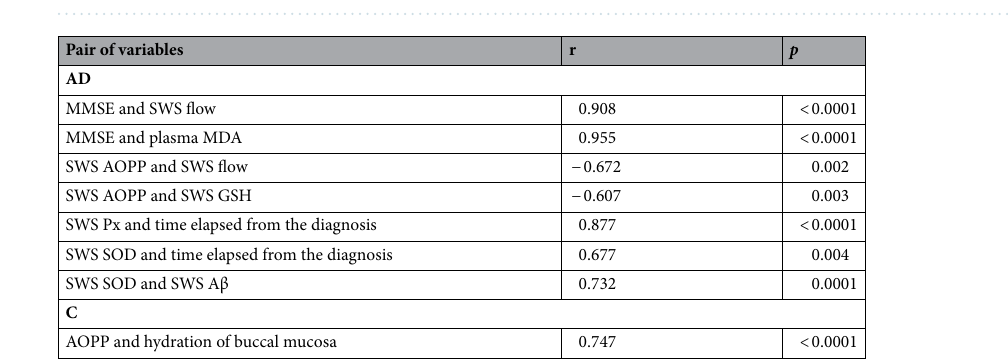
Table 6. Statistically significant correlations between redox biomarkers and clinical parameters. AD— Alzheimer’s disease; MMSE—Mini-Mental State Examination; SWS—stimulated whole saliva; MDA— malondialdehyde; AOPP—advanced oxidation protein products; GSH—reduced glutathione; GPx— glutathione peroxidase; SOD—superoxide dismutase; Aβ—amyloid β; C—control group.